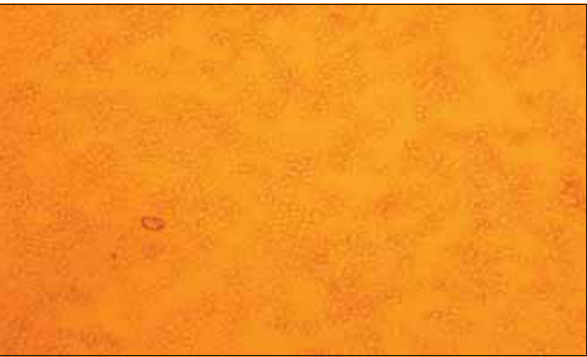
Figure-2: Unstained BHK cell inoculated with suspected Op samples showing rounding CPE in cell (Positive results of presence of FMDV in samples).